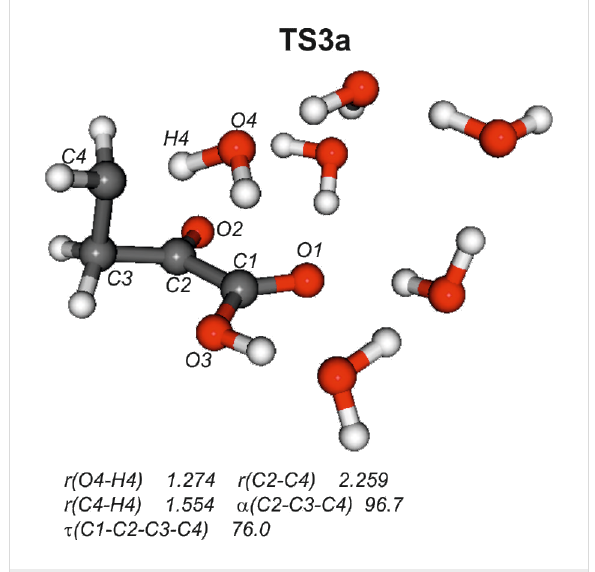
Figure 3: Calculated structure of transition state TS3a . Distances are given in angstrom (Å), angles in degrees.